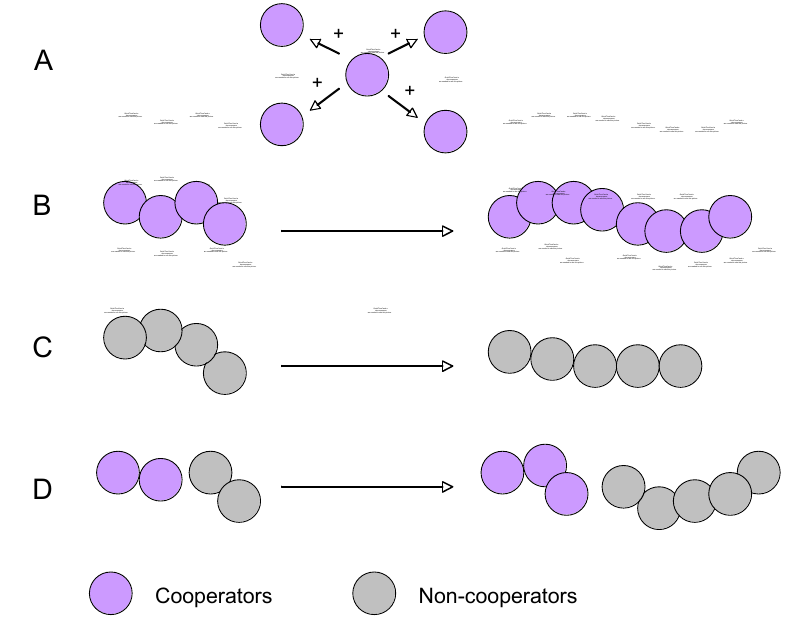
Figure 3. A schematic diagram describing quorum sensing-mediated social cooperation and conflict. Social cooperation provides benefits to the population but has a cost for the cooperative cells. Cooperative cells provide fitness benefits to the entire population ( A ) and have a higher productivity or yield in an exoproduct ( B ). However, non-cooperative cells (cheaters) may have the lower productivity ( C ), but can exploit the benefits from the cooperative cells without contribution in mixed populations ( D